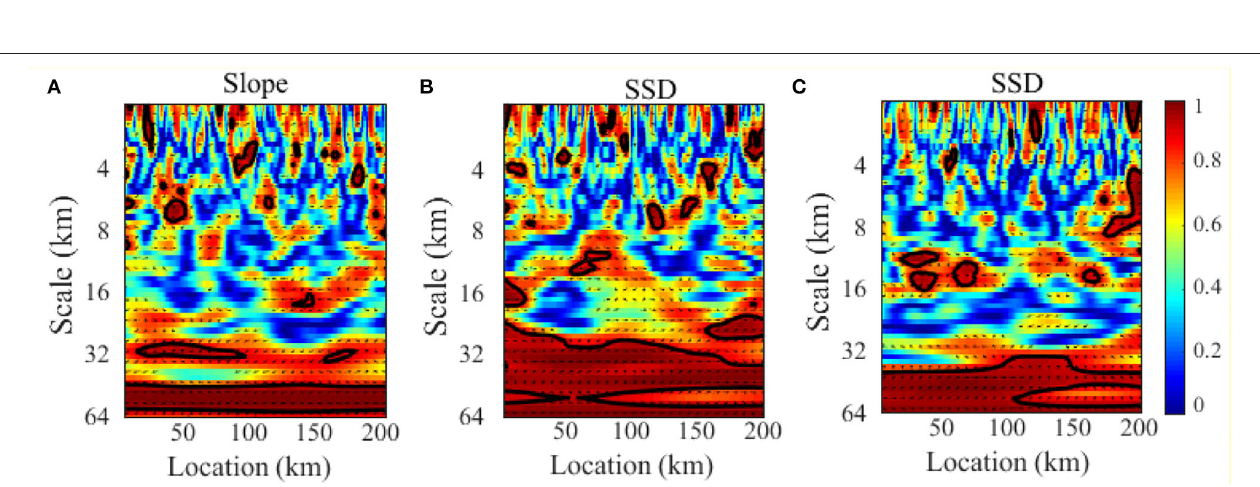
FIGURE 4 | Partial wavelet coherency (PWC) between the temporal change of soil nitrogen density (SND T ) and single predictor variable after excluding the effect of the other variables along the (A) cool-temperate (slope), (B) mid-temperate (SSD), and (C) warm-temperate (SSD) transects. The direction of the arrow shows the type of correlation (the right direction is positive and the left direction is negative), and the solid black lines show significant bivariate wavelet coherence (BWC) at a 95% confidence